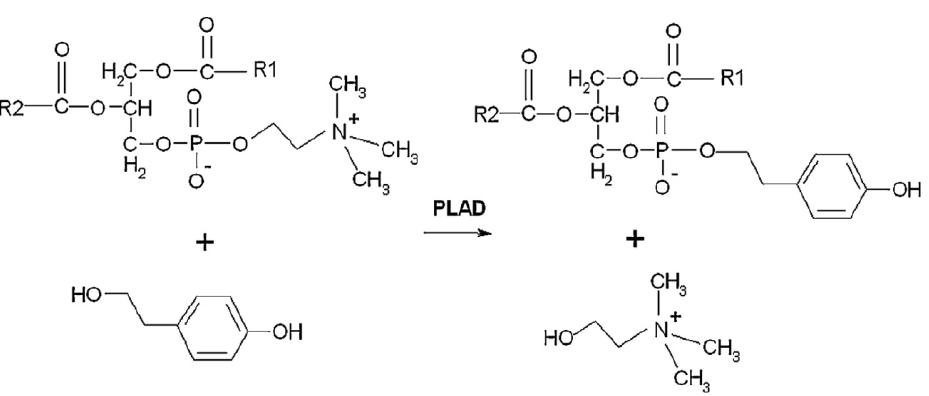
Figure 10. Schematic presentation of phospholipase D (PLD) transphosphatidylation reaction. Casado, Reglero and Torres used a food−grade phospholipase D from Actinamadure sp. to produce highly purified phosphatidyl−tyrosol in a GRAS (Generally Recognized as Safe) biphasic medium. Reprinted with permission from Ref. [70]. 2013, Elsevier.